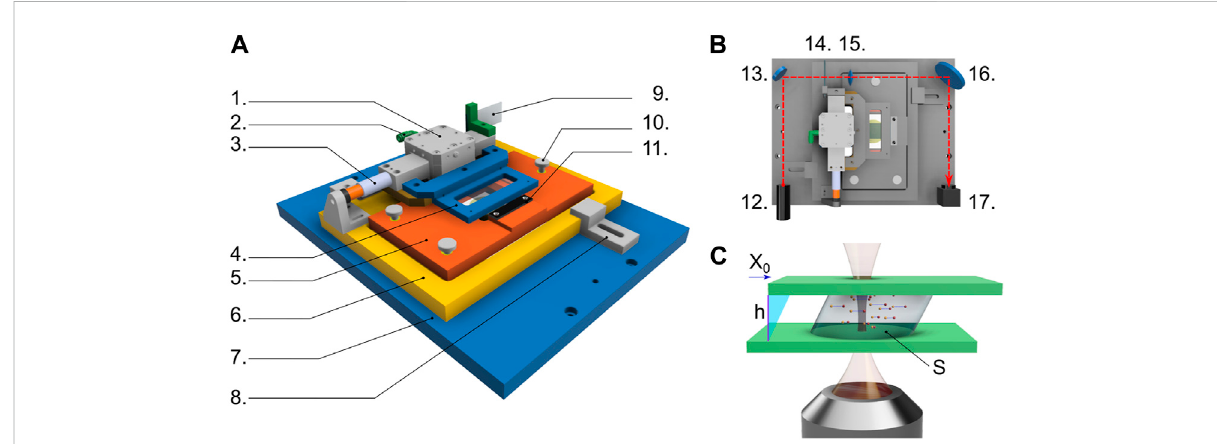
FIGURE 1 (A) Sketch of the key components of the shear cell: air bearing (1), inlet for compressed air (2), voice coil (3), holder for the upper glass slide (4), support of the lower glass slide (5), mounting base of the shear cell (6), microscope stage (7), clamping system fi xing the cell mounting base to the microscopestage(8),groundglass(9),micrometricscrewsforcontrollingthegapdistance h andtheparallelismoftheglassslides(10),pass-through holeenablingimagingwiththeunderlyingobjective(11).Themovingpartoftheshearcell,drivenbythevoicecoilactuator,iscomposedbythe moving parts of (1,3) plus parts (4,9). The entire block (5) lays on part (6) and its orientation can be fi nely tuned using the micrometric screws (10). (B) Top view of the shear cell also including the optical pathway and components used for the strain measurement via speckle fi eld formation and detection: laser light source (12), mirror (13), ground glass solidly moving with the upper part of the shear cell (14), lens (15), mirror (16), and camera (17). (C) Sketchoftheimaginggeometryoftheshearcell:thesampleofcross-sectionalarea S isenclosedbetweenthetwoglassslidesplacedatgap distance h ; as the upper glass is moved by X 0 driven by the voice coil, the sample is sheared; the subsequent sample motion is monitored in time by imaging tracer particles with a long working distance objective, which can be positioned at different distance from the lower glass slide allowing to follow the sample dynamics at any selected plane z within the